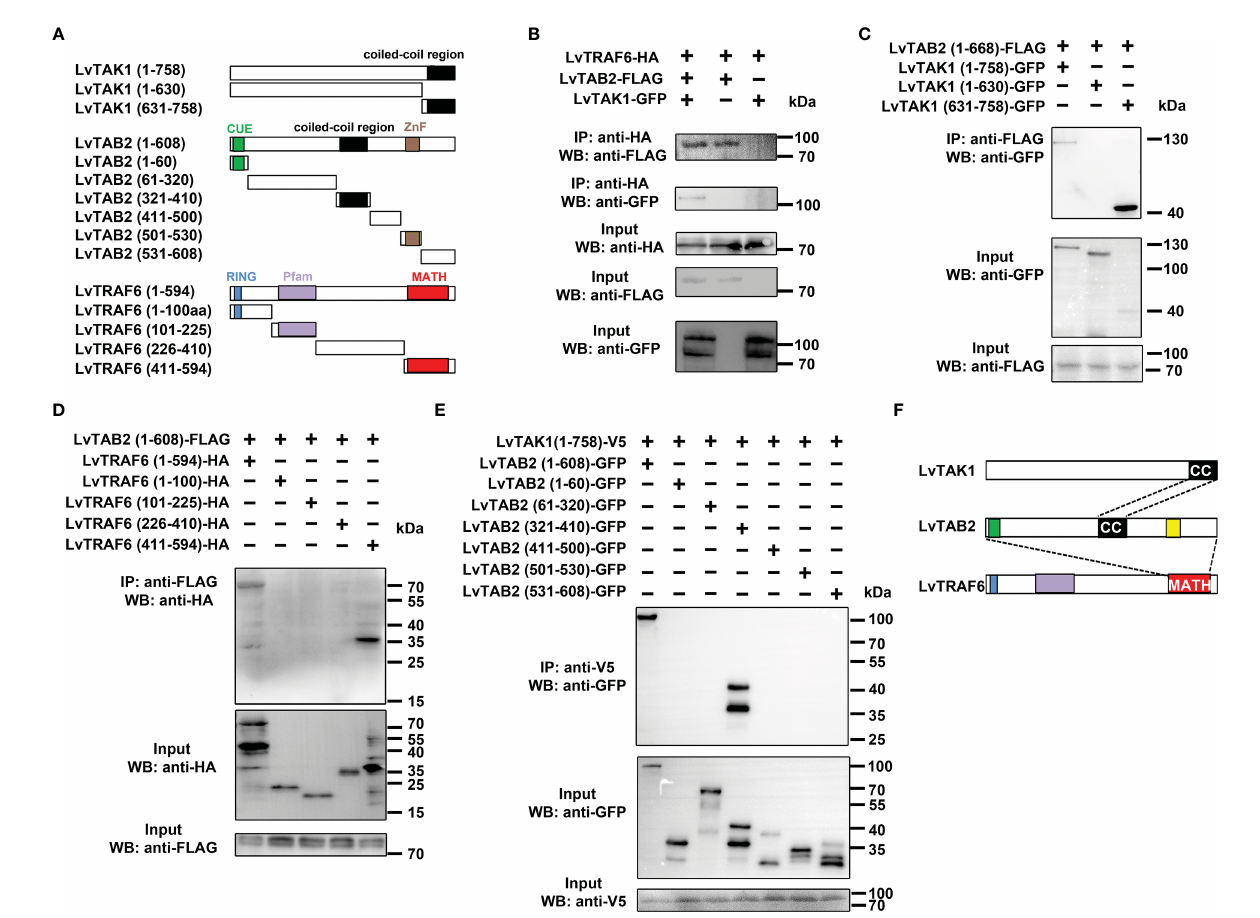
FIGURE 3 LvTRAF6, LvTAB2 and LvTAK1 could form a TRAF6-TAB2-TAK1 complex. (A) LvTAB2, LvTAK1, and LvTRAF6 interaction (B) Schematic representations of LvTAK1, LvTAB2, and LvTRAF6 segments. (C) Interaction of LvTAB2 and LvTAK1 segments (D) Interaction of LvTAB2 and LvTRAF6 segments (E) Interaction of LvTAK1 and LvTAB2 segments (F) Schematic representations of the LvTRAF6-LvTAB2-LvTAK1